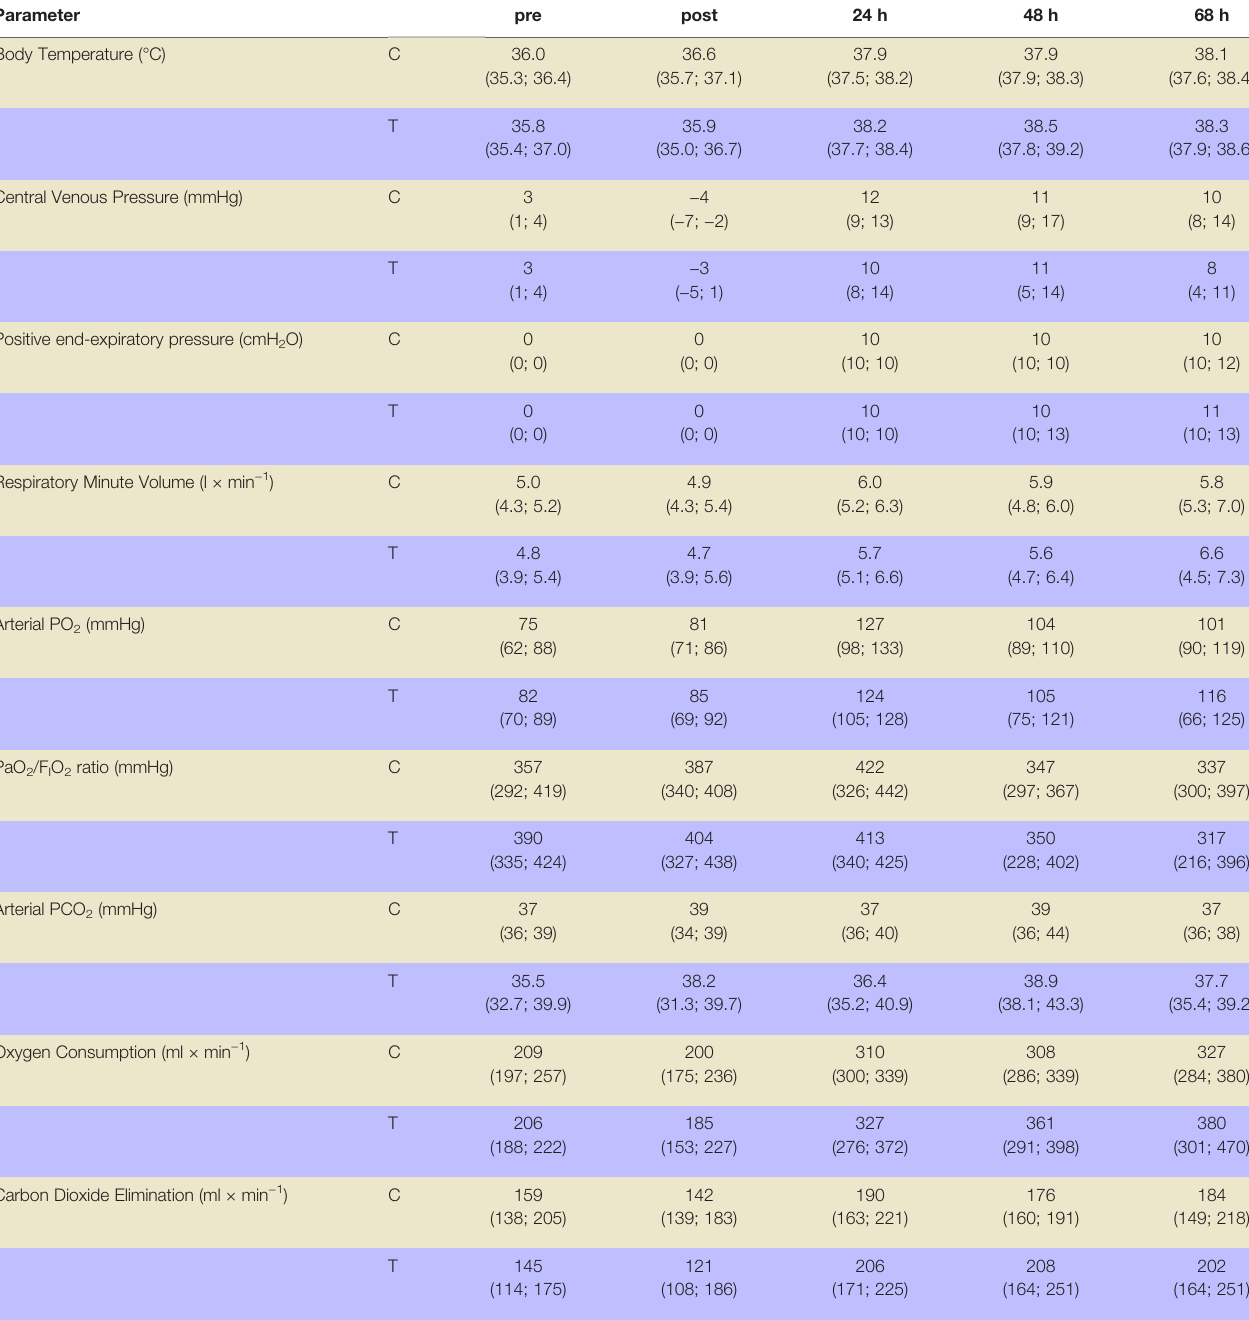
TABLE 1 | Systemic and respiratory parameters before (pre) and after 3 h of hemorrhagic shock (post) as well as 24 h, 48 h, and 68 h after